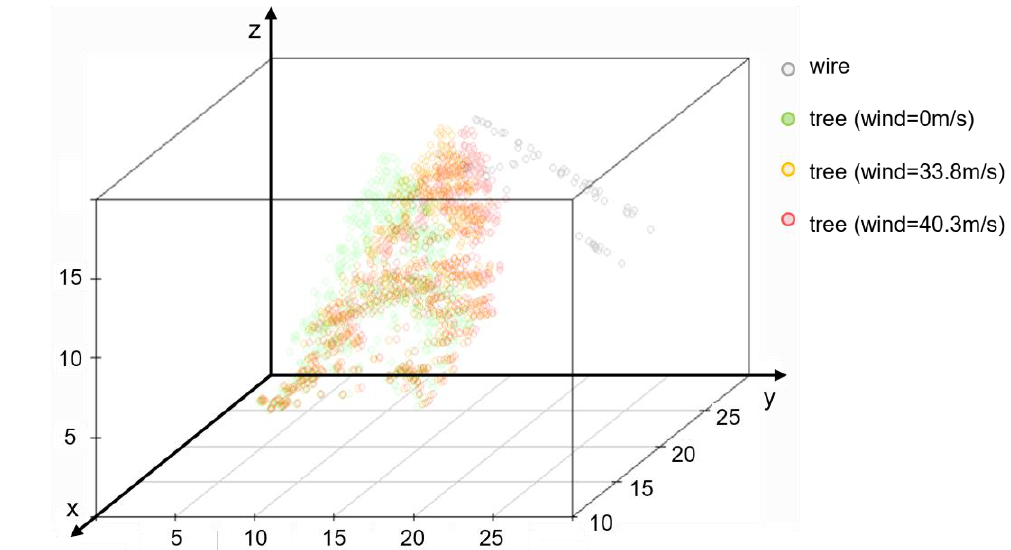
Figure 9. Schematic diagram of how the tree is deflected toward the wire by wind loading.